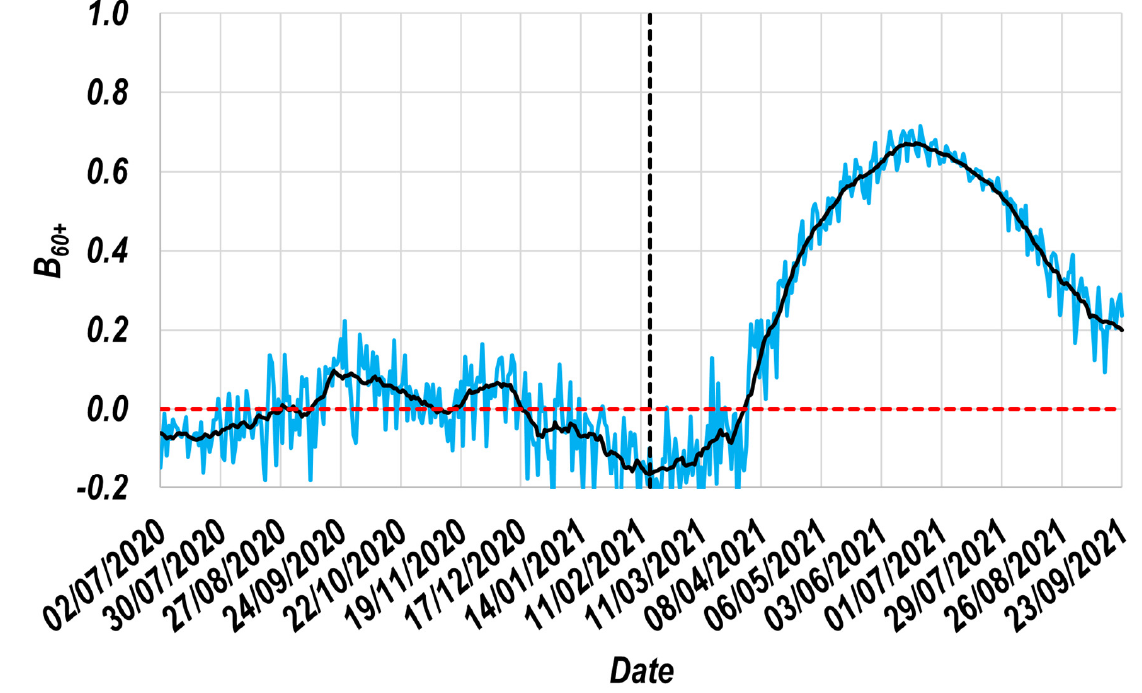
Figure 3. Beneficial effect induced by the vaccines administrated to Mexicans. Original data for 60+ group (___). Smoothed data (using a centered moving average of the 15 th order [47]) for 60+ group (___). Reference markers: Date at which the vaccination process of the 60+ group started (- - -) [44], and zero value (- - -).